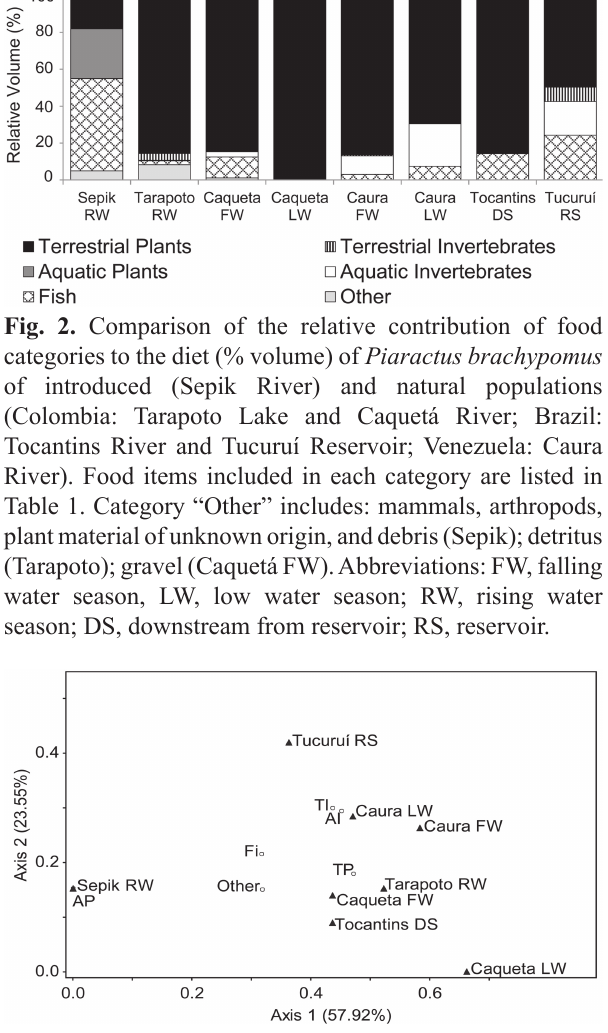
Fig. 3. Bray Curtis (Polar) ordination of arcsine-square root transformed volumetric proportions of food